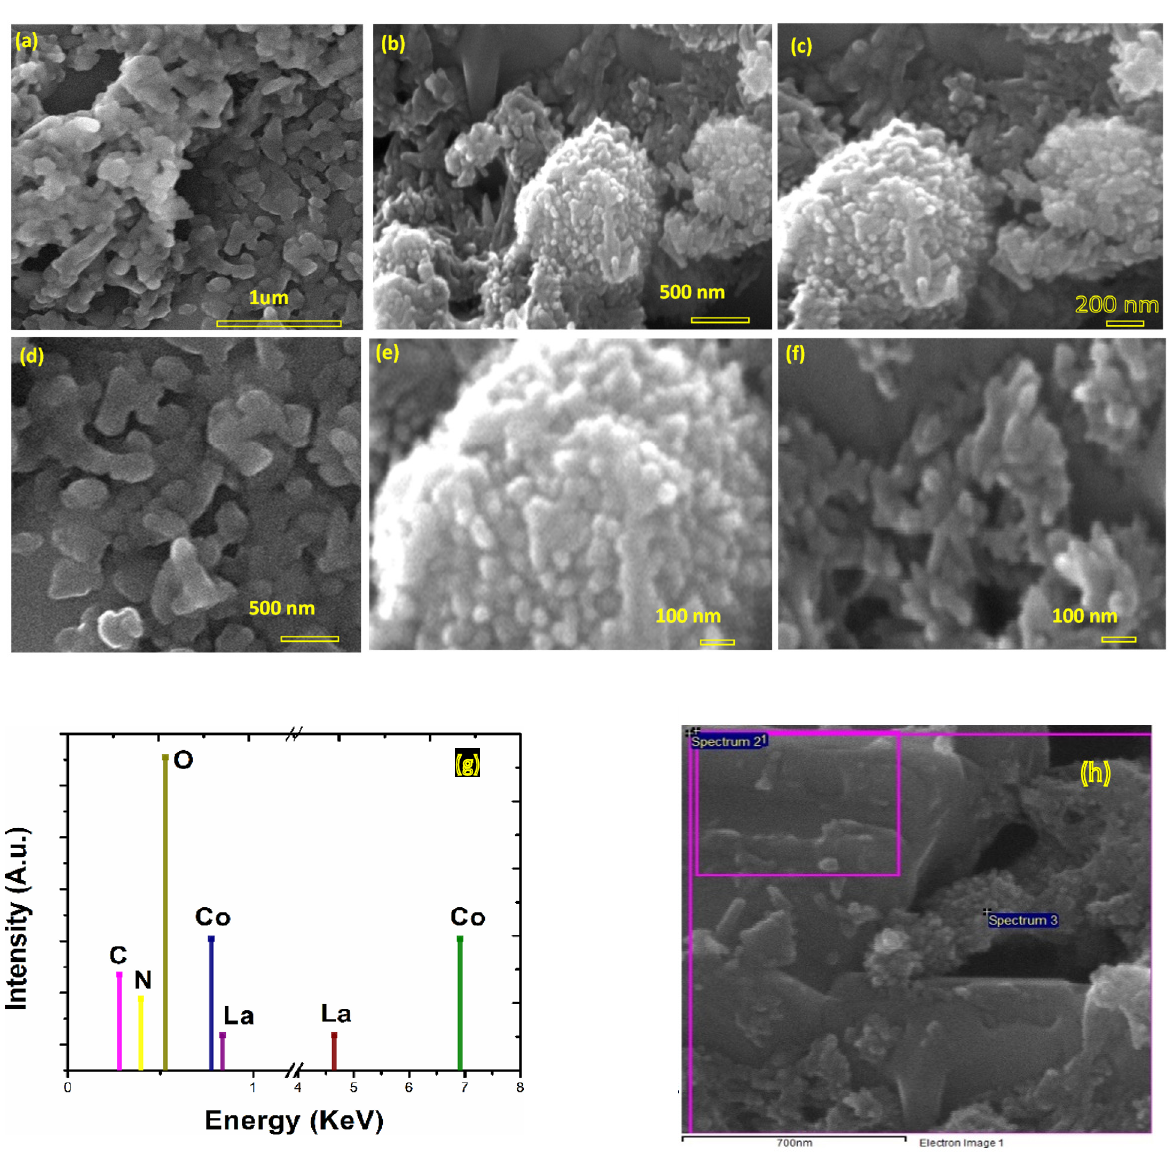
Figure 2. Low- and high-resolution SEM micrograph of g-C 3 N 4 nanoflakes ( a , d ). High-resolution micrographs of La 2 O 3 –CoO–g-C 3 N 4 nanocomposites showing nanoparticles clusters entrenched with g-C 3 N 4 nanoflakes ( b , e ) and ( c , f ). EDX spectrum showing characteristic elemental peaks